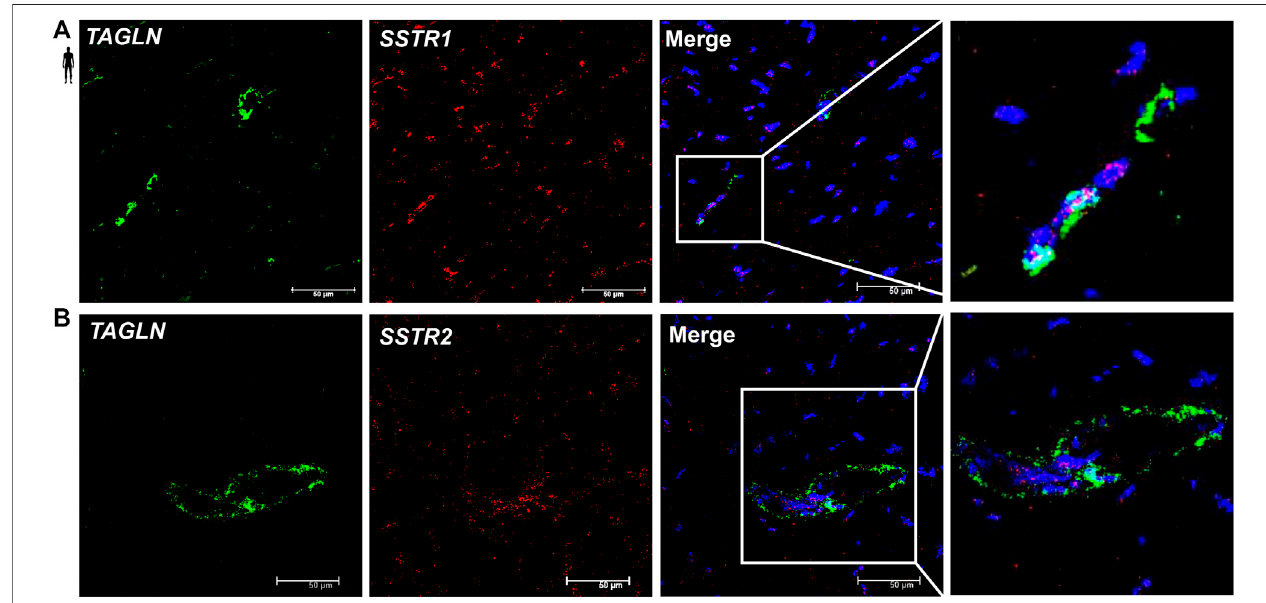
FIGURE 7 | Representative confocal microscopy images of RNA Scope ® - SSTR1 (A) and SSTR2 (B) mRNA expression in histological samples of human control leftventricle.NucleiwerestainedwithDAPI(blue).Fluorescein-labeledtyramide(green)wasusedtovisualizemRNAof TAGLN (smoothmusclemarker)andCy3-labeled tyramide (red) was used to visualize mRNA of SSTR1 or SSTR2 , respectively. Scale bar represents 50 µm.